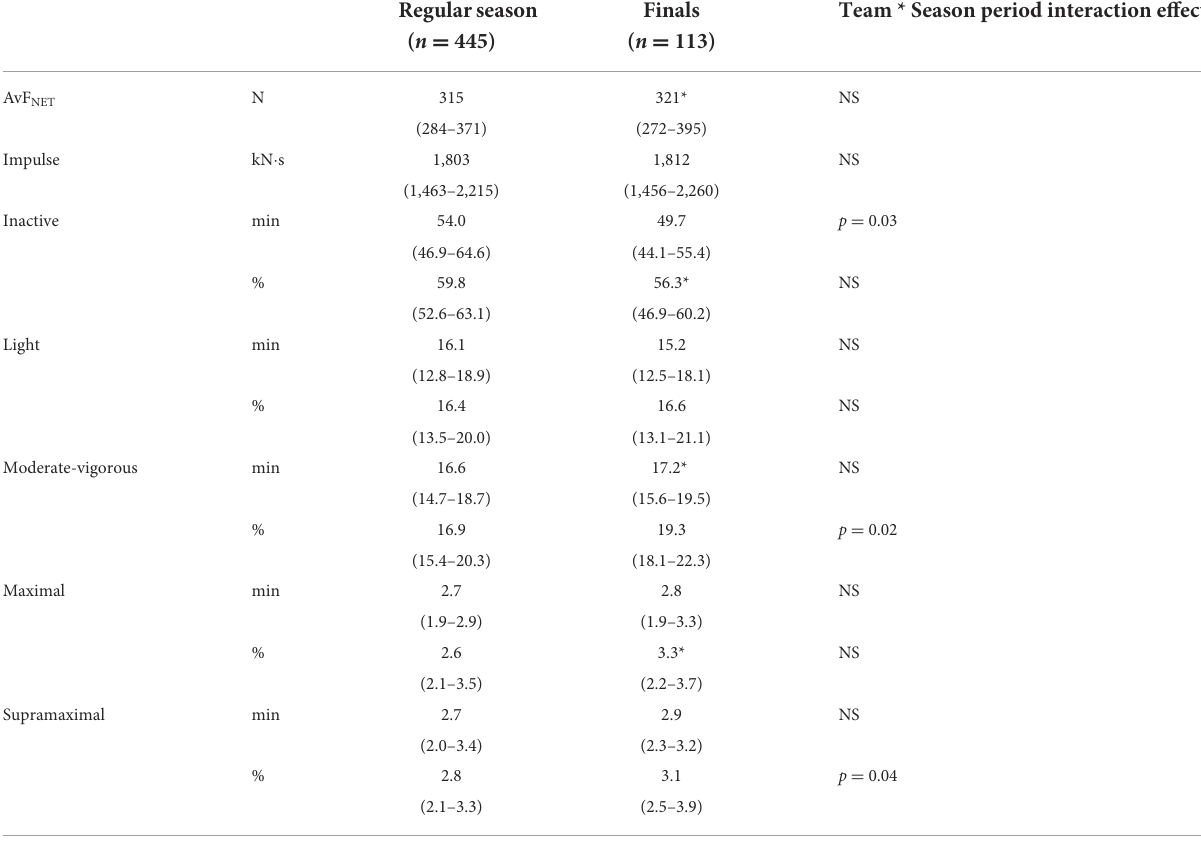
TABLE 3 On-court activity during training sessions in the regular season and finals.